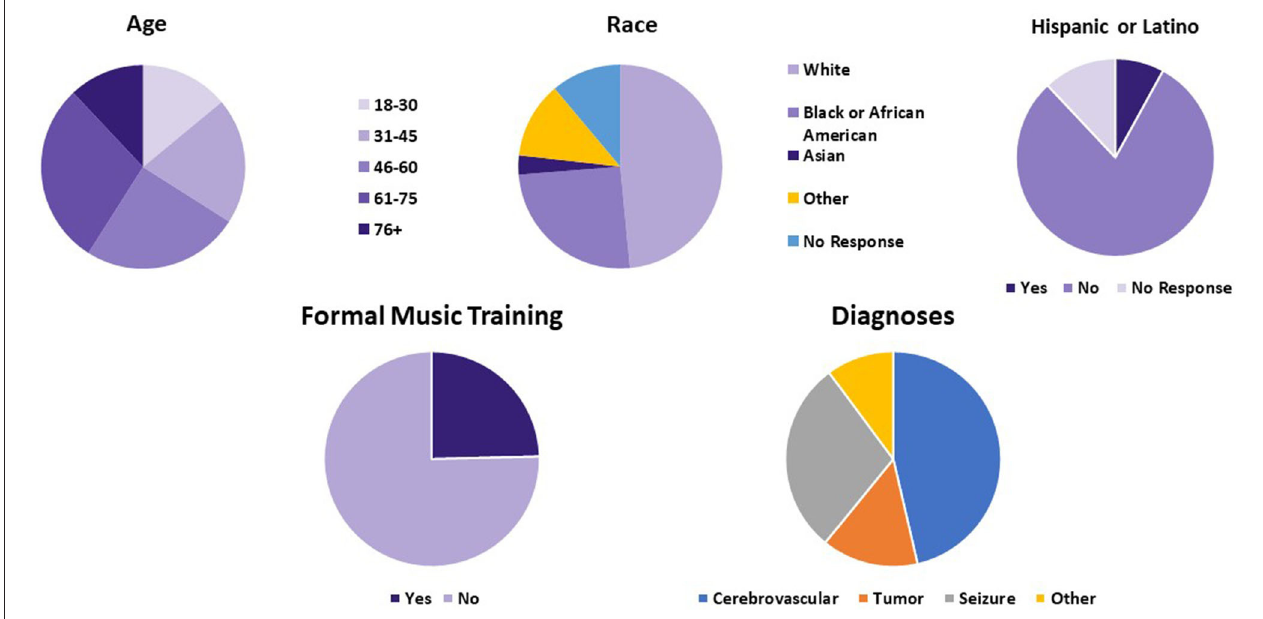
FIGURE 2 | Demographic information based on pre-intervention surveys. Age, diagnosis, ethnic background, and history of formal music training of patients who finished telemusic intervention are demonstrated. NSG, neurosurgical cases.